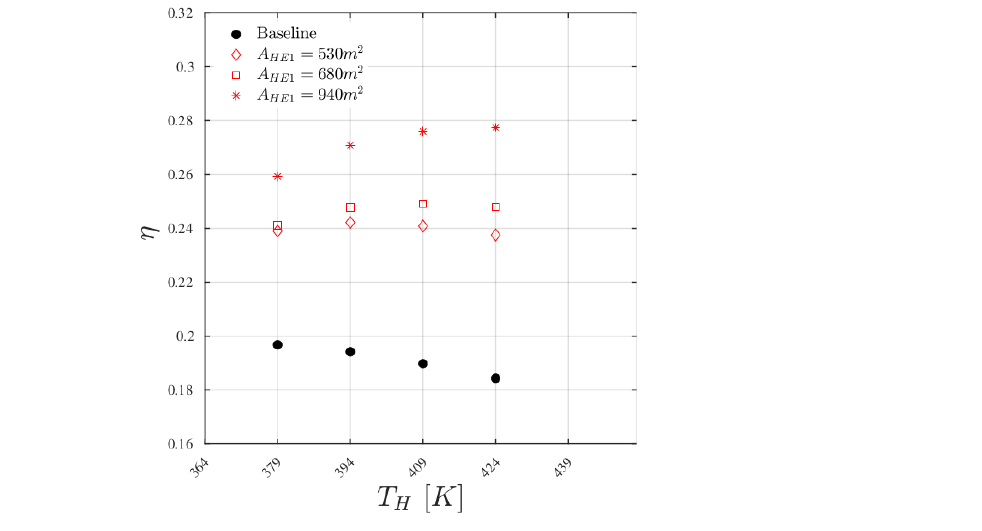
Figure 4. Drying efficiency for Baseline and Scenario 1 plotted against drying air inlet temperature ( T H